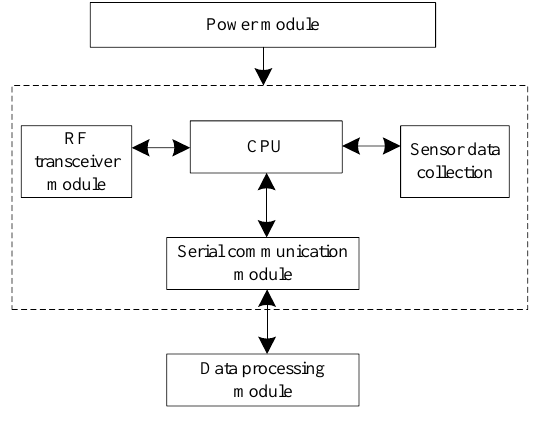
Figure 4. Diagram of CC2430 chip